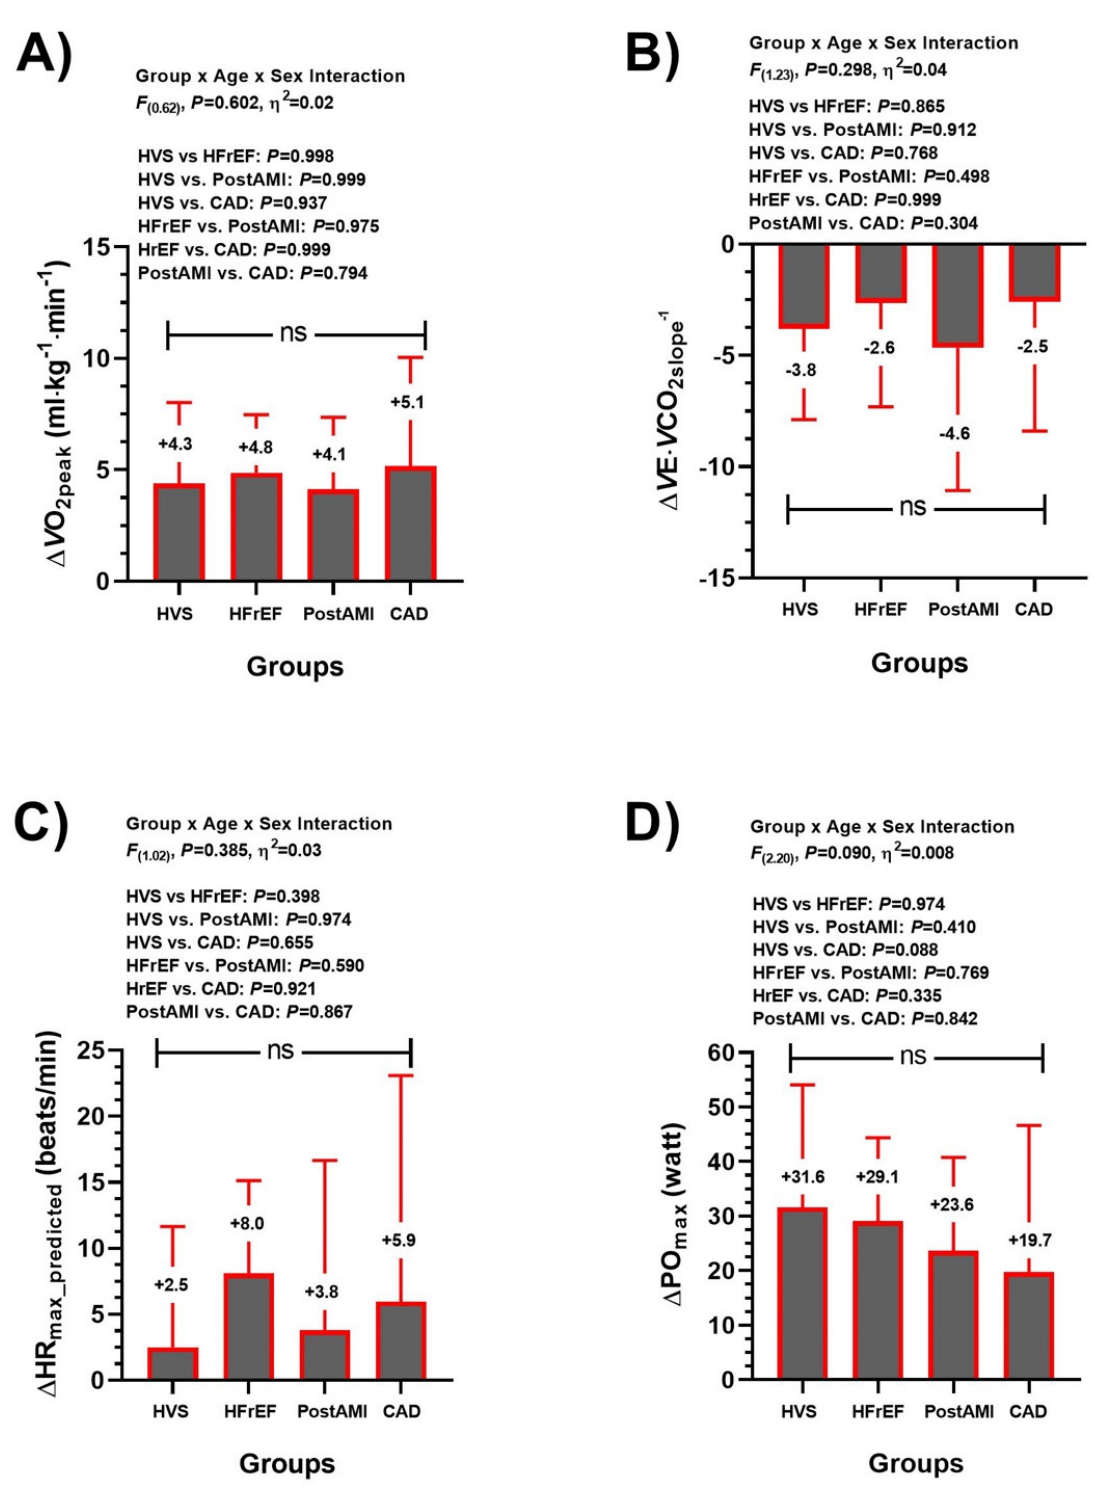
Figure 2. Delta changes ( ∆ ) from pre-post calculation in cardiorespiratory fitness (panel ( A ) [VO 2peak ] maximum oxygen consumption, panel ( B ) [VE · VCO 2slope − 1 ] slope of increase in ventilation in response to CO 2 production, panel ( C ) [HR max-pred ] Heart Rate maximum predicted and in performance [PO max ] Power Output panel ( D )) parameters. Heart valve surgery (HVS), heart failure with ejection fraction (HFrEF), post-acute myocardial infarction (post-AMI), and in coronary artery disease (CAD) patients. (ns) Non-significant changes among groups.